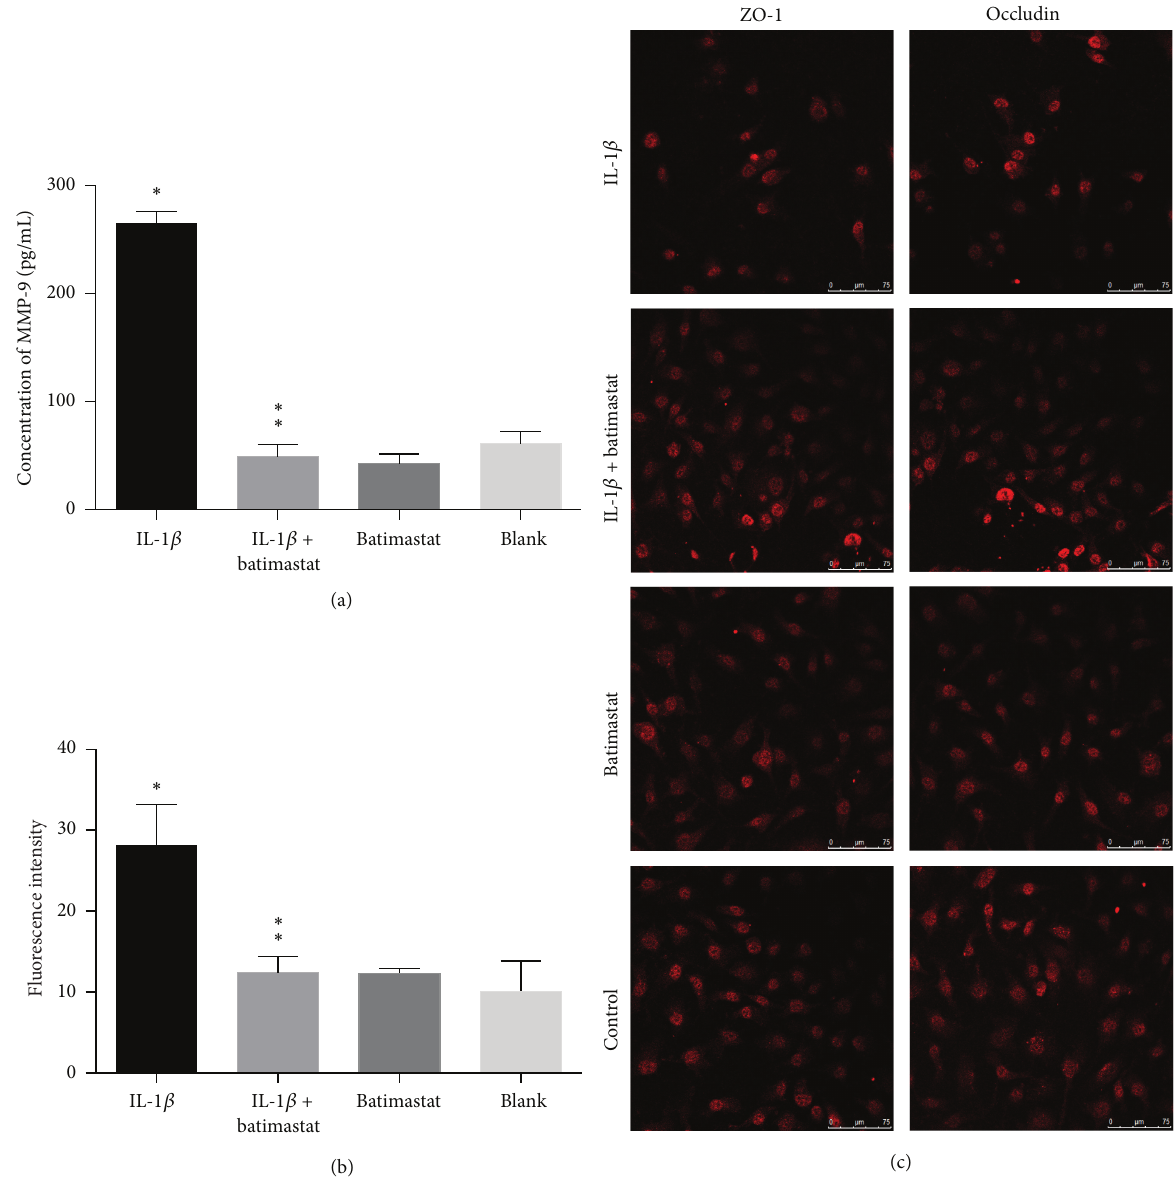
Figure 5: IL-1 𝛽 -inducedtight junction disruptionand endothelial coculturesystem hyperpermeability were attenuated by MMP-9inhibition. (a) The levels of MMP-9 were significantly higher in IL-1 𝛽 groups than in control groups ( ∗ 𝑃 < 0.05 ). Batimastat treatment significantly reduced the level of MMP-9 versus vehicle group ( ∗∗ 𝑃 < 0.05 ). (b) Exposure to IL-1 𝛽 significantly increased the permeability to FITC-dextran compared with the control groups ( ∗ 𝑃 < 0.05 ), which was decreased by batimastat in coculture system ( ∗∗ 𝑃 < 0.05 ). (c) Confocal microscopy images of immunofluorescence staining of ZO-1 and occludin demonstrating the protective effect of batimastat against IL-1 𝛽 -induced tight junction